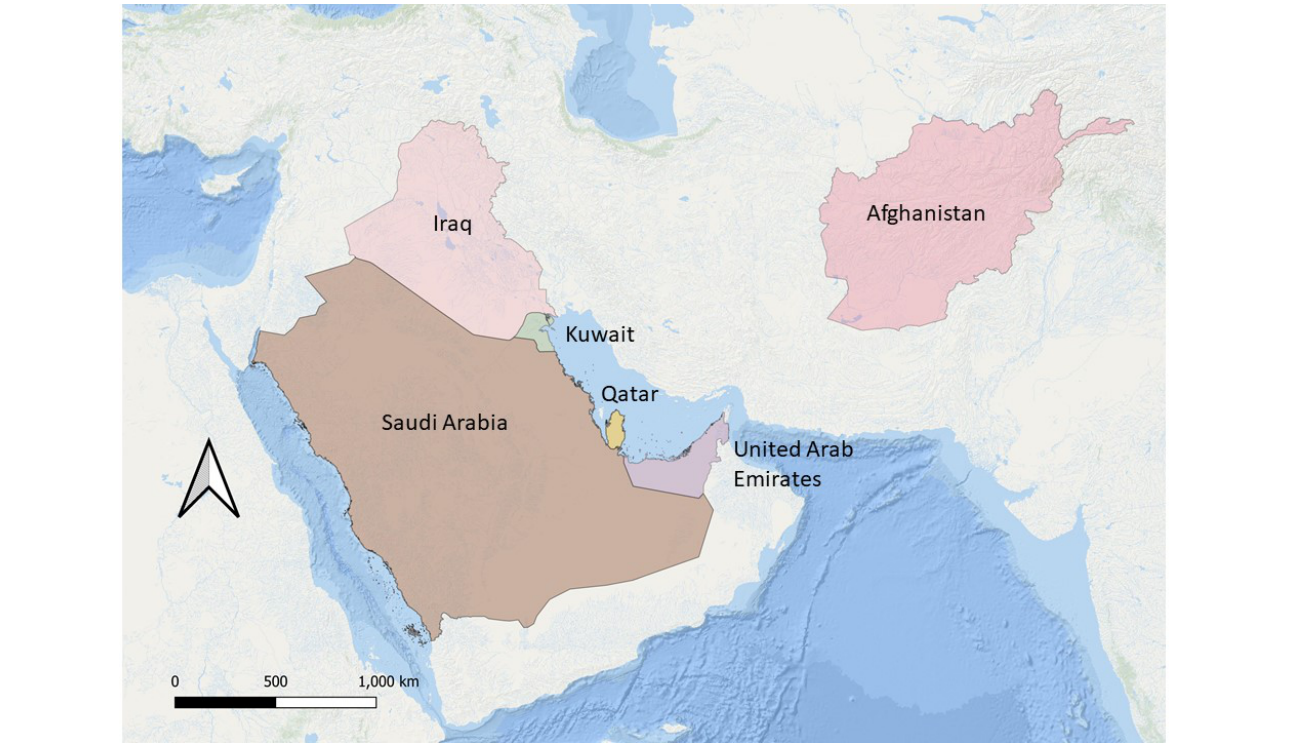
Figure 1. Map of the study